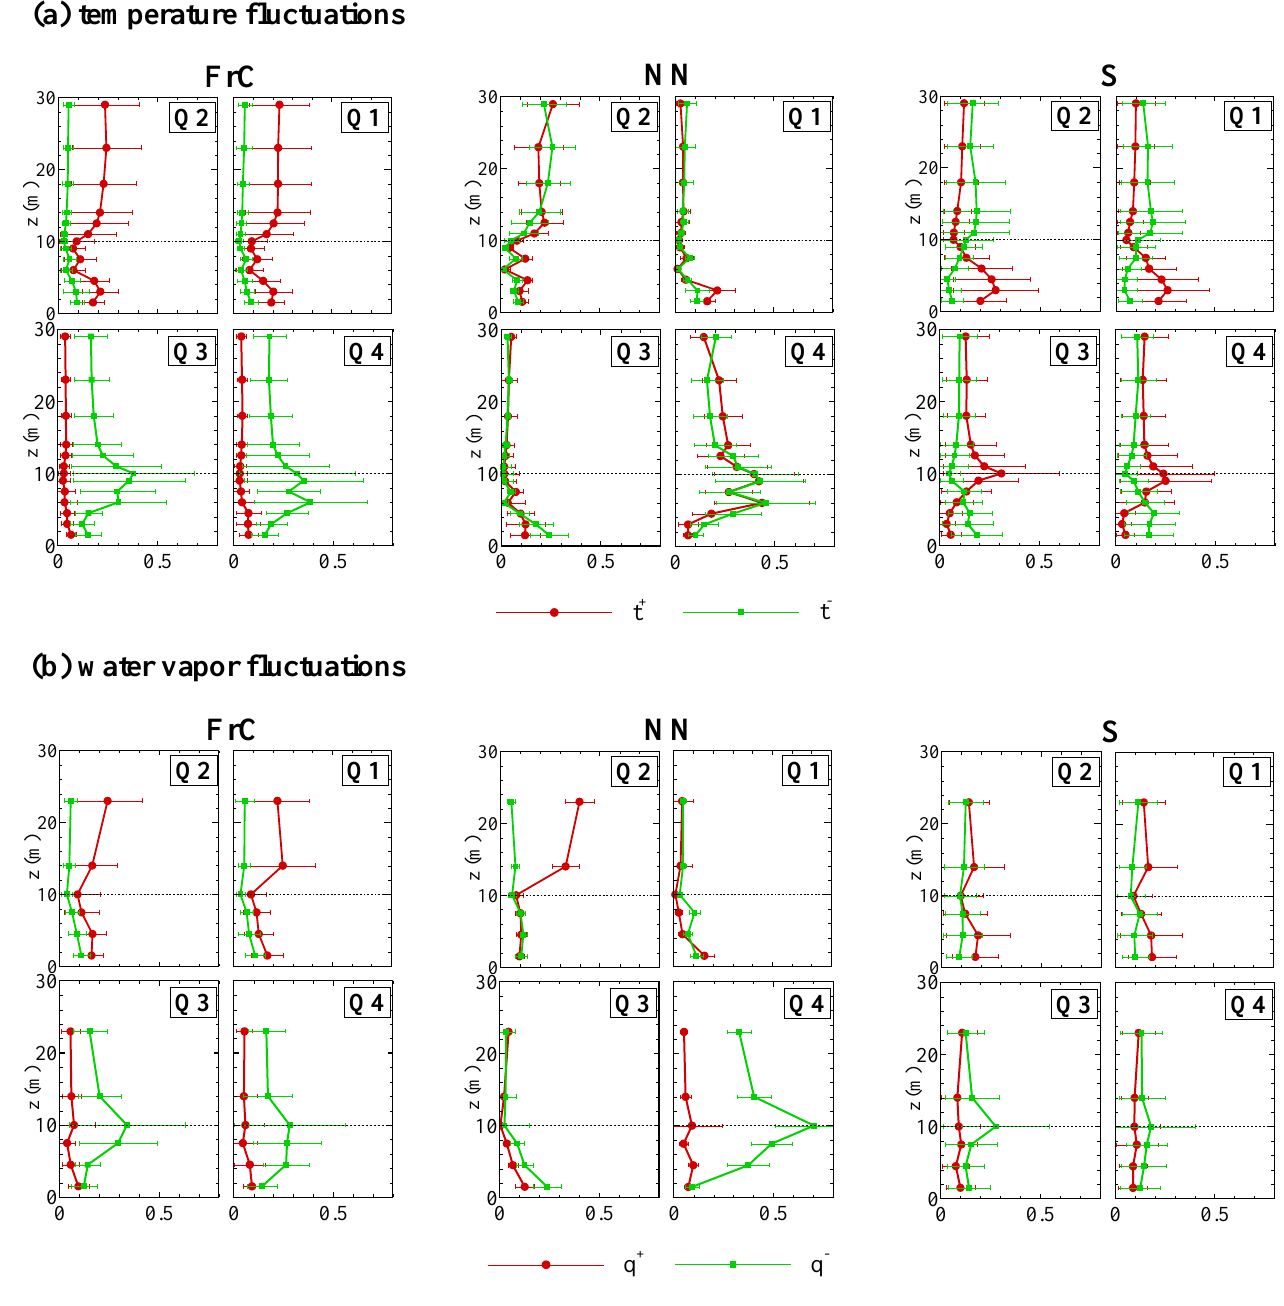
Fig. 3. Same as Fig. 2, but for the period